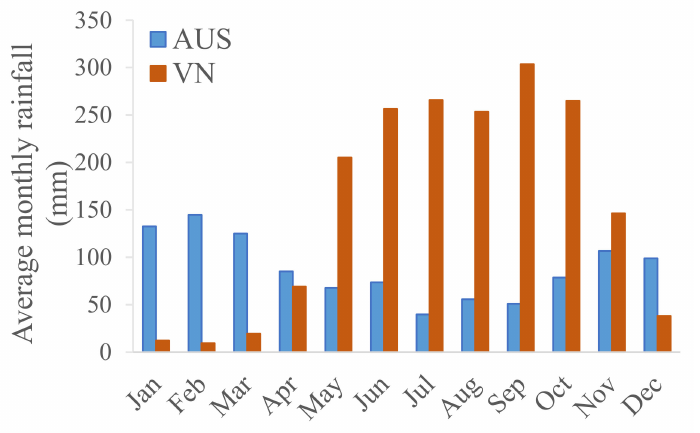
Figure 2. Average monthly rainfall of the selected stations in Australia and